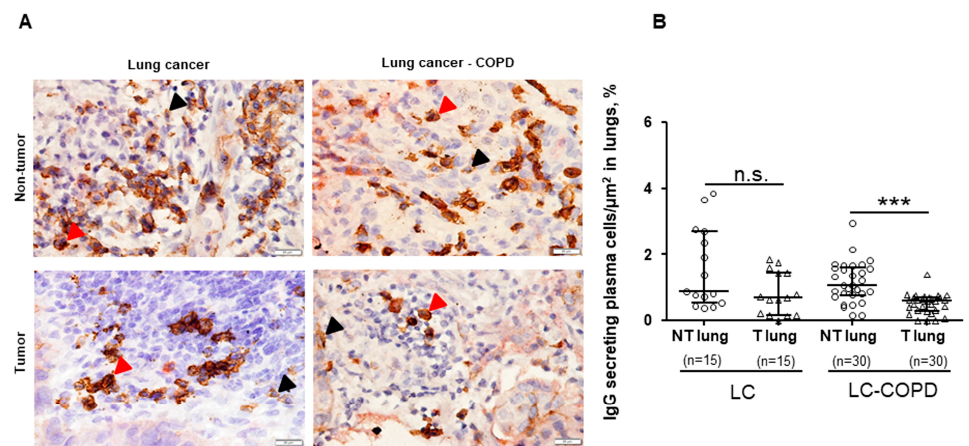
Figure 3. ( A ) Representative examples of double immunohistochemical staining for IgG-secreting plasma cells (CD138-IgG positively stained plasma cells) in LC and LC–COPD patients, respectively. All types of plasma cells (CD138 + ) are stained only in brown (black arrow), while IgG-secreting plasma cells (CD138 + IgG + ) are specifically stained with both brown and red. ( B ) Median and interquartile ranges between 75th and 25th percentiles of number of IgG-secreting plasma cells in the total measured area. Black-stained regions within the lungs correspond to anthracosis. Comparisons were made between the non-tumor (NT) and tumor (T) samples and the LC and LC–COPD groups. For technical reasons, the number of patients in each group or type of samples (tumor and non-tumor) may di ff er. Statistical significance: ***, p ≤ 0.001 between tumor and non-tumor lungs in LC–COPD patients. Definition of abbreviations: LC, lung cancer; COPD, chronic obstructive pulmonary disease; CD, cluster of di ff erentiation; Ig, immunoglobulin.